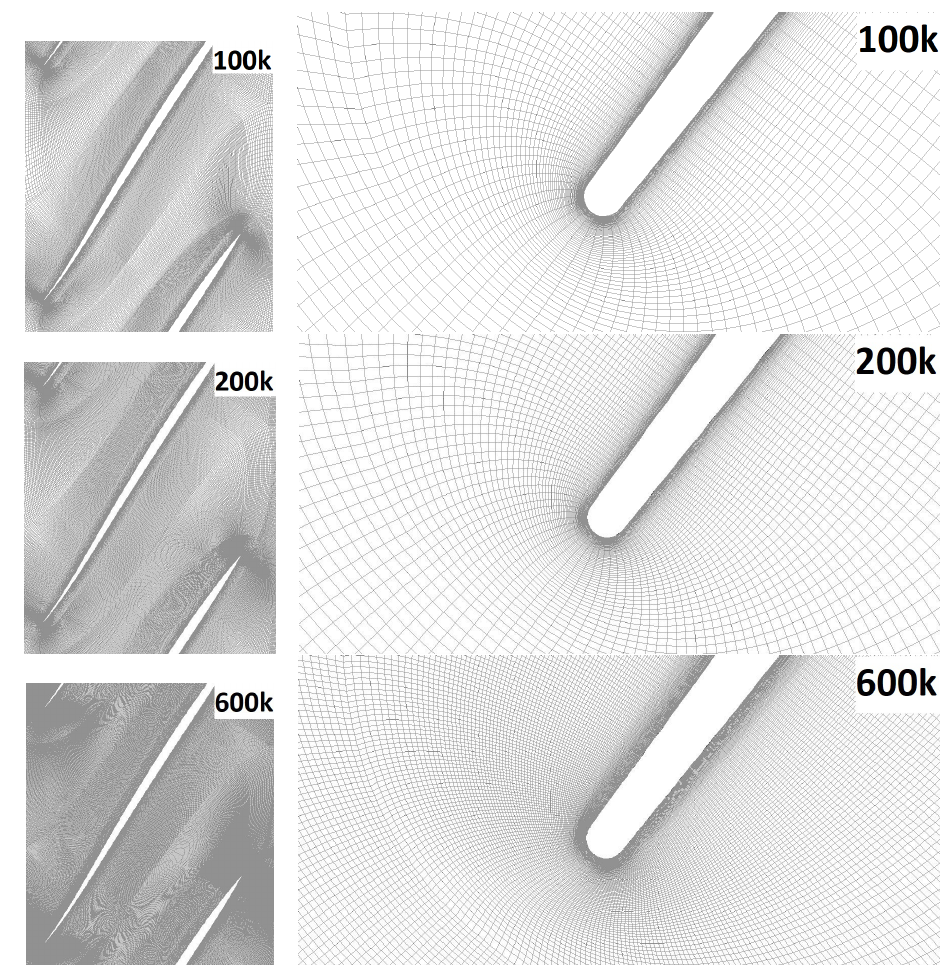
Figure 2. Blade passage and detail of the leading edge of the three grid